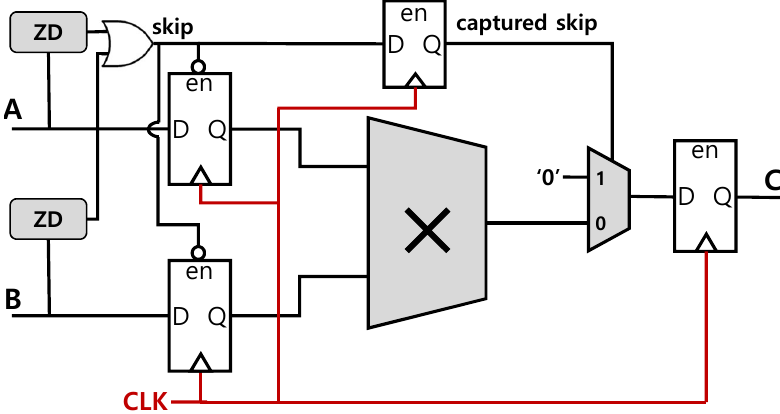
Figure 10. A circuit architecture for the zero-skip